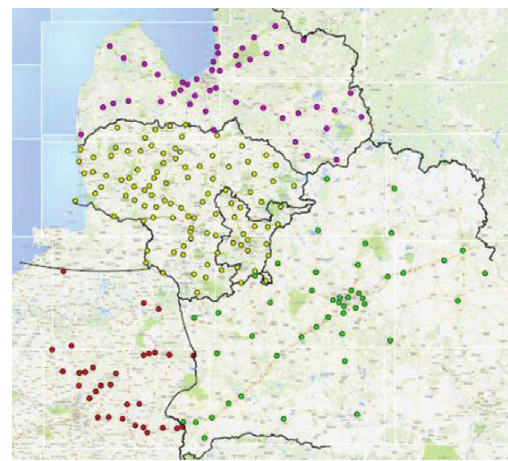
Fig. 2. Location of the weather stations in